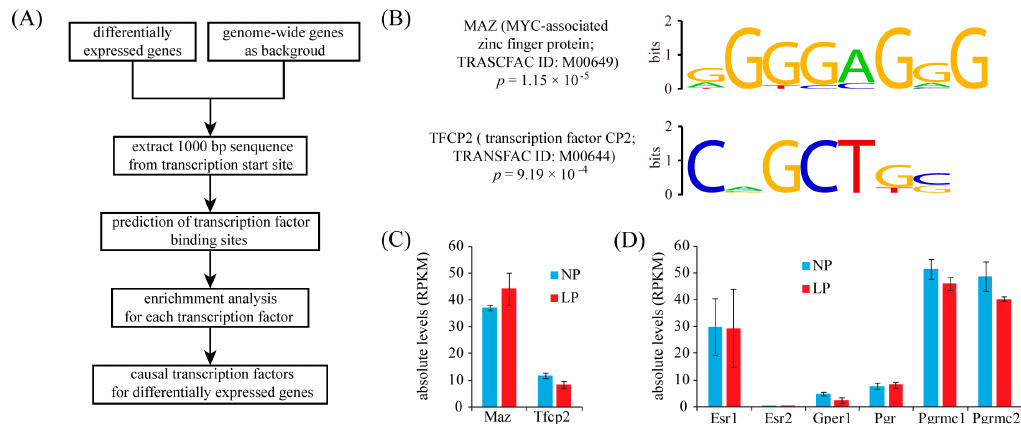
Figure 4. Enrichment of transcription factor binding sites (TFBS) in up-regulated genes. ( A ) The workflow for TFBS enrichment analysis; ( B ) The sequence logo display for two transcription factors whose binding sites are significantly enriched in up-regulated genes; ( C ) Bar plot showing absolute expression levels for MAZ and TFCP2; ( D ) Bar plot showing absolute expression levels for estrogen receptors and progesterone receptors. Esr1, estrogen receptor α ; Esr2, estrogen receptor β ; Gpre1, G protein-coupled estrogen receptor 1; Pgr, progesterone receptor; Pgrmc1, progesterone receptor membrane component 1; Pgrmc2, progesterone receptor membrane component 2.